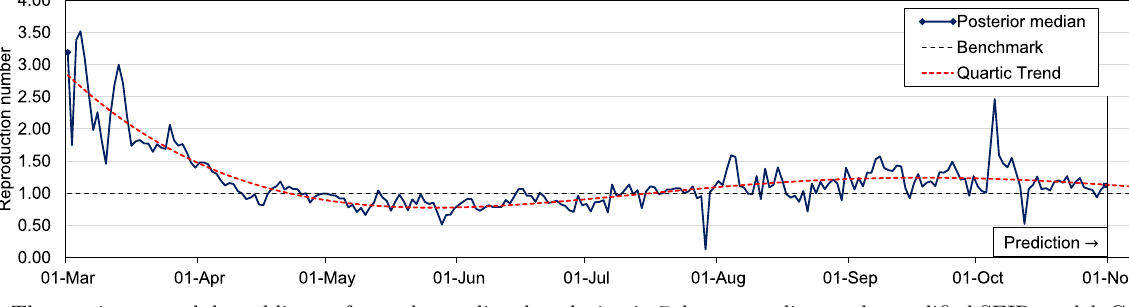
Fig. 6. The continuous red dotted lines refer to the predicted evolution in 7 days according to the modi fi ed SEIR model. Coverage: United Kingdom region, updated on 31 October